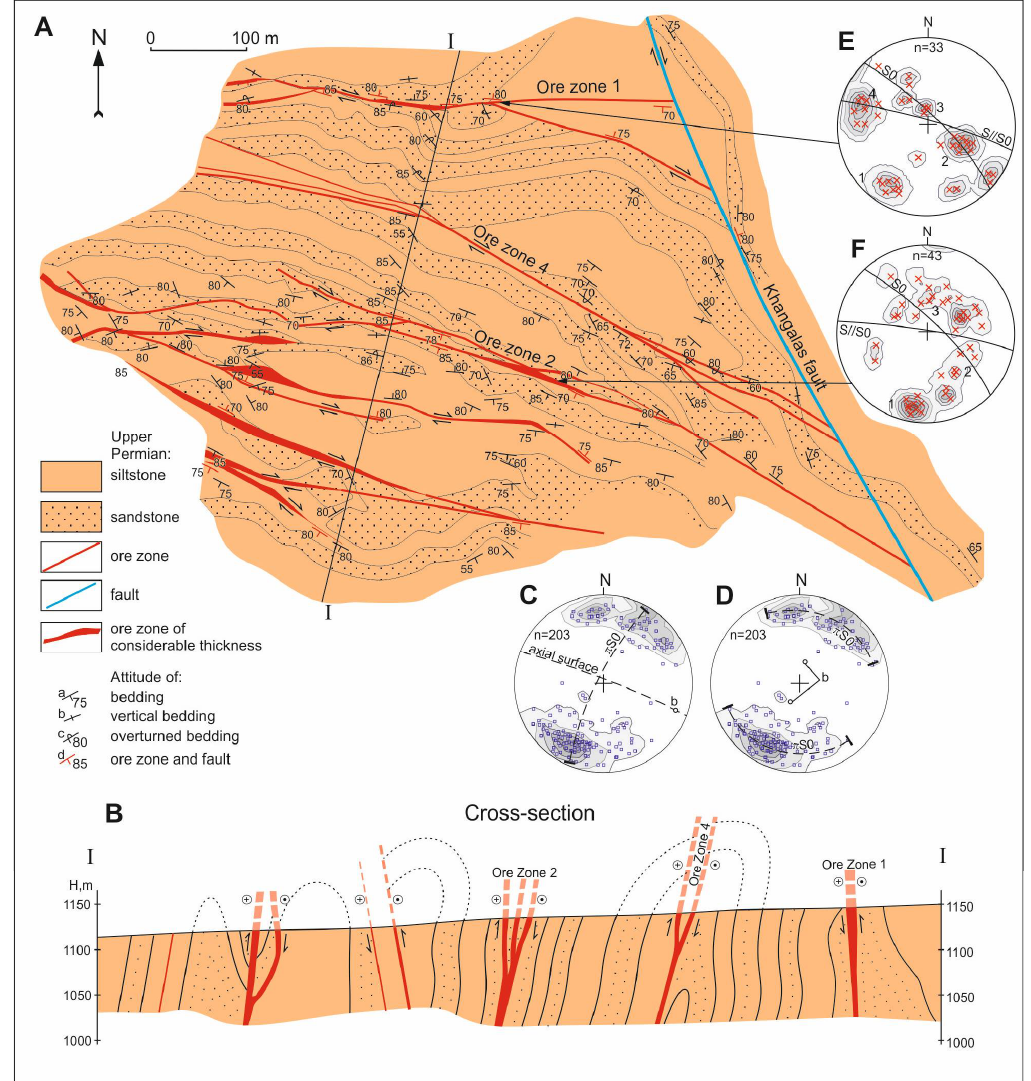
Figure 5. Geological sketch map and section of the Nagornoye occurrence. In Figure ( A ), the I-I line shows the position of the cross-section ( B ). The diagrams show: ( C , D ) bedding poles; ( E ) quartz vein poles in Ore Zone 1; ( F ) quartz vein poles in Ore Zone 2. Contours of poles to planes (per 2% area).